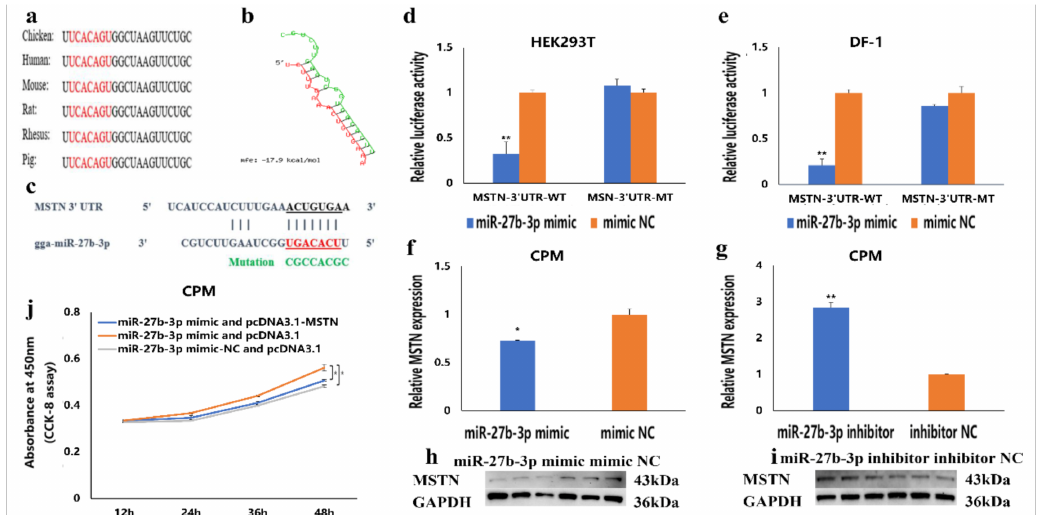
Figure 4. MSTN is the target gene of miR-27b-3p. ( a ) The seed region of miR-27b-3p. ( b ) The potential interaction model between miR-27b-3p and MSTN 3 (cid:48) UTR from RNAhybrid. ( c ) The potential binding site sequence of miR-27b-3p on MSTN 3 (cid:48) UTR. The seed sequences and mutant sequences were highlighted in red and green, respectively. ( d , e ) The luciferase assays were performed by the co-transfection of wild-type or mutant MSTN 3 (cid:48) UTR with a miR-27b-3p mimic or mimic-NC in HEK293T and DF-1 cells. ( f – i ) After transfection of miR-27b-3p mimics, miR-27b-3p inhibitor, or NC, the expression of MSTN was determined by qRT-PCR and Western Blot. ( j ) CCK-8 detection in rescue experiment. In all graphs, the results are shown as mean ± S.E.M (standard error of the mean) ( n = 3). Statistical significance of differences between means was assessed using the unpaired Student’s t -test (* p < 0.05; ** p < 0.01) vs. NC (negative